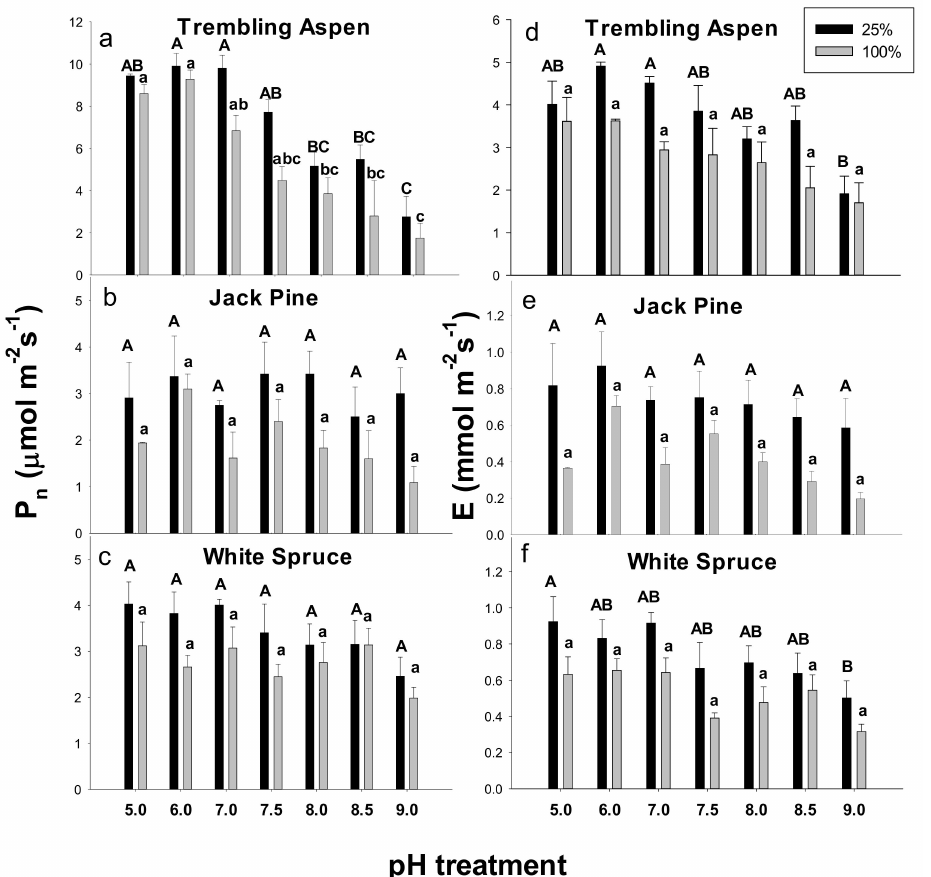
Figure 2. E ff ects of pH treatments and nutrition level (supplied with 25% and 100% Hoagland’s solution) on net photosynthesis (Pn) ( a – c ) and transpiration rates (E) ( d – f ) in trembling aspen ( a , b ), jack pine ( c , d ), and white spruce ( e , f ). Di ff erent letters above the bars (uppercase letters for 25% Hoagland’s solution and lowercase letters for 100% Hoagland’s solution) indicate significant di ff erences ( α = 0.05) between pH treatments within each plant species. Means ( n = 8) ± SE are